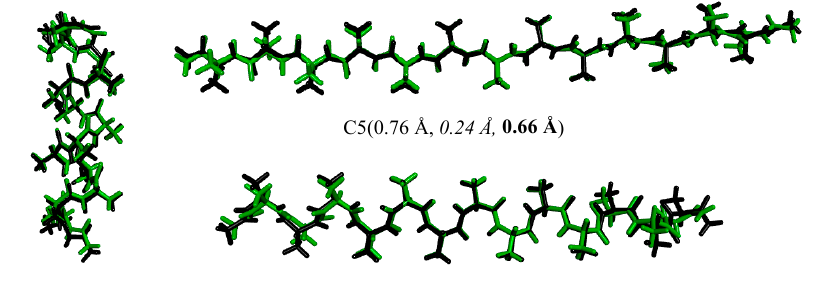
Figure 5. Superposition of the B3LYP/6-31G(d) structures (black) and the force field ones (green) of AcAla 13 NH 2 . The values in parentheses are RMSEs of the force field structures relative to the B3LYP structure of the heavy atoms. AMBER99sb: normal; AMOEBAbio18: italic; our potential: bold.